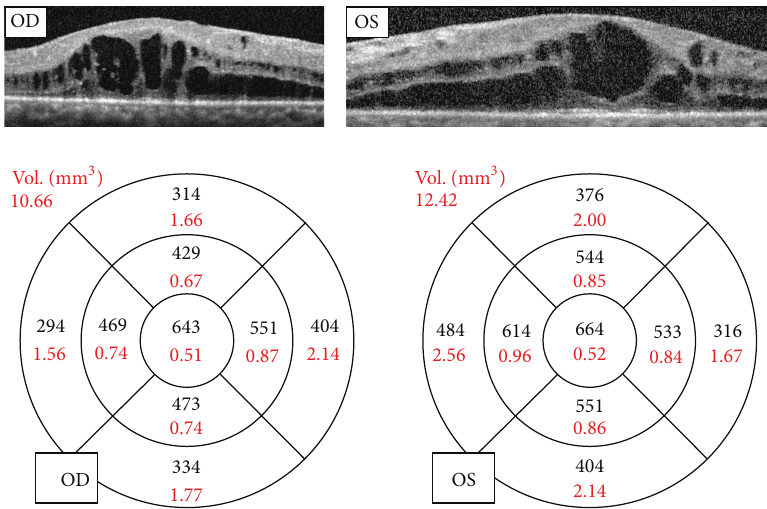
Figure 4: OCT spectral domain: diffuse retinal thickening with cystic areas of low